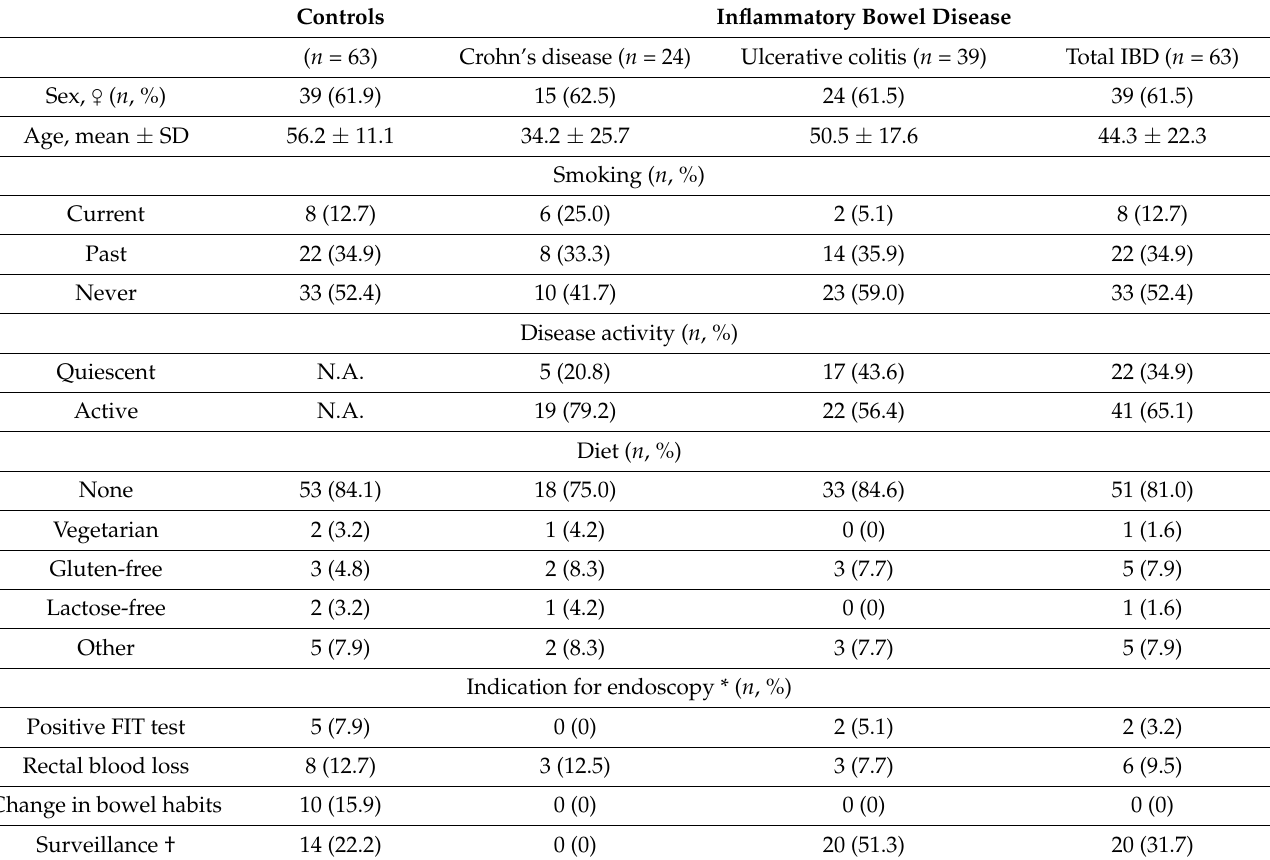
Table 1. Baseline